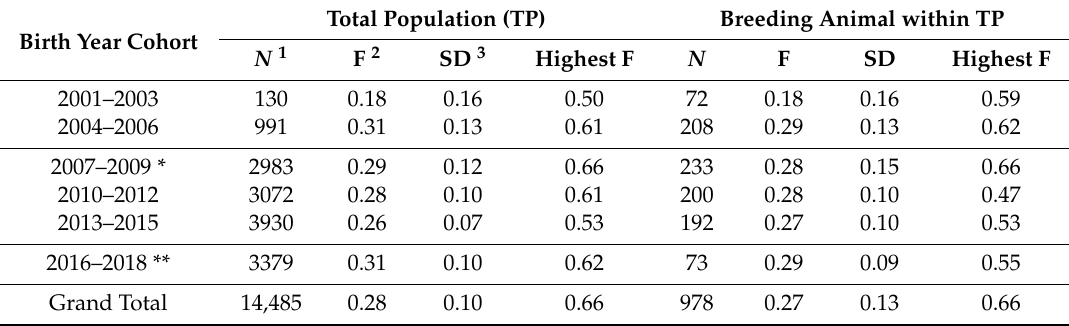
Table 4. Inbreeding coe ffi cient (F) in the total population (TP) e in the breeding animal within TP from the start of breed recovery project to